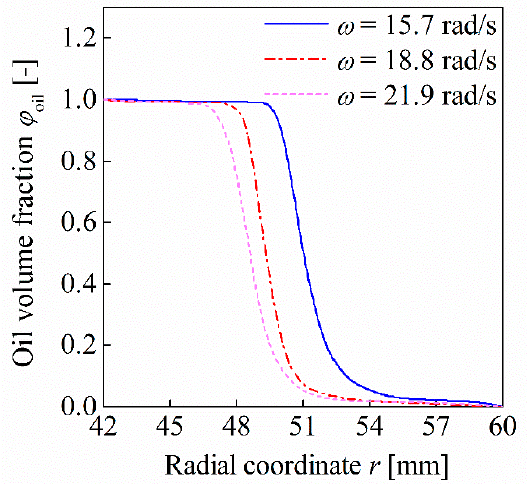
Figure6. Averageoilvolumefractioncurvesatdi ff erentradialpositionswithdi ff erentangularvelocities. Figure 6. Average oil volume fraction curves at different radial positions with different angular velocities.